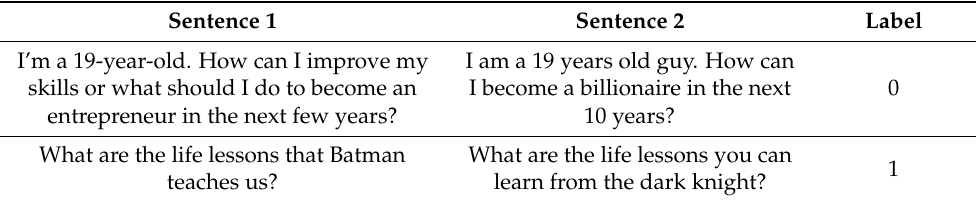
Table 1. Example of English sentence pairs and labels.